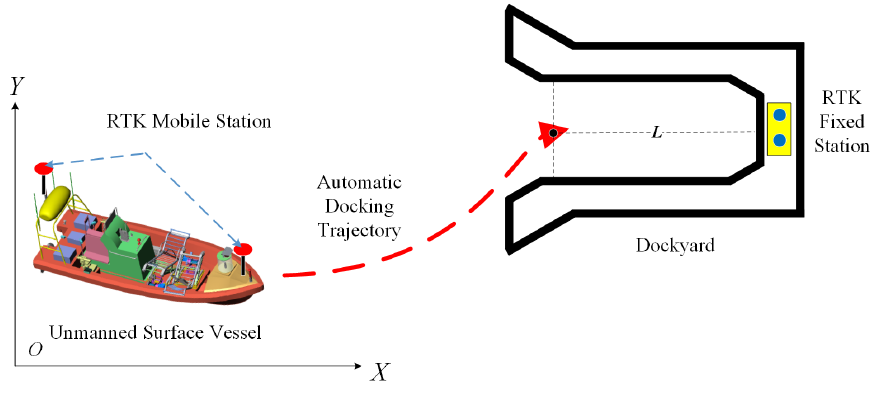
Figure 3. The framework of the automatic docking trajectory.